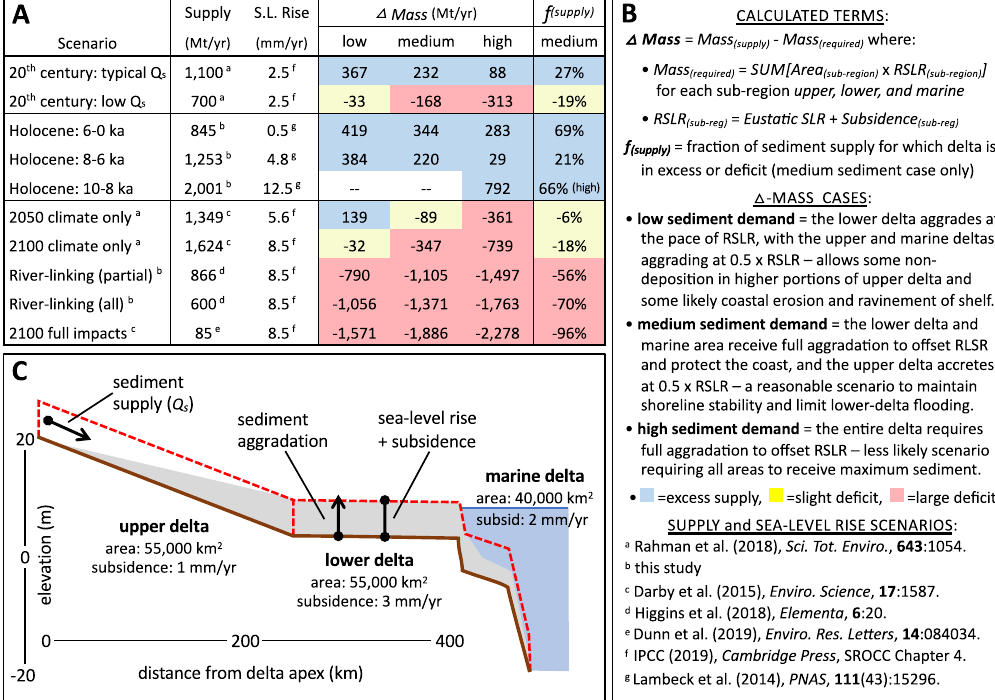
Fig. 3 | Modern, Holocene, and future mass-balance calculations comparing ratesofsedimentdeliveryagainstthemassrequiredtooffsetsea-levelriseand subsidence. A Summary of the mass-balance scenarios, showing input values for sediment supply and sea-level rise and the calculated outputs for Δ Mass and f (supply) . Calculations of required mass for each scenario can be found in Table S4.